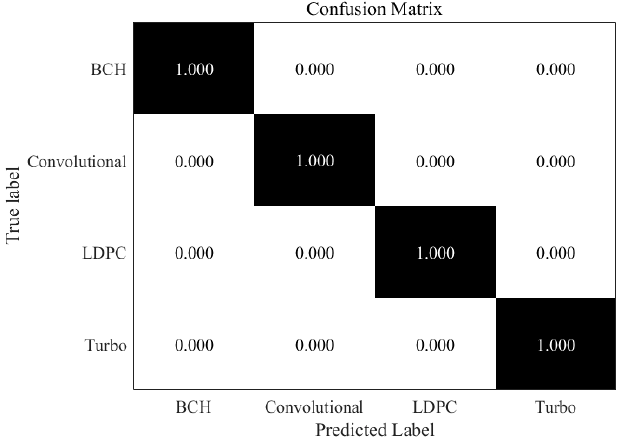
Figure 5. Confusion matrix for improved RNN trained at 10 dB SNR.